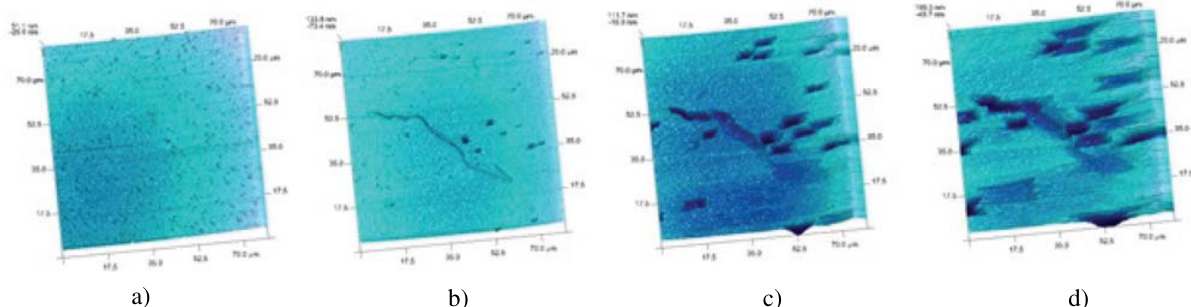
Figure 8: Surface topography of the (001) face of the large crystals exposed to the dissolution media recorded at time points 0 (a), 1 h (b), 3 h (c) and 6 h (d) respectively at 500× magnification